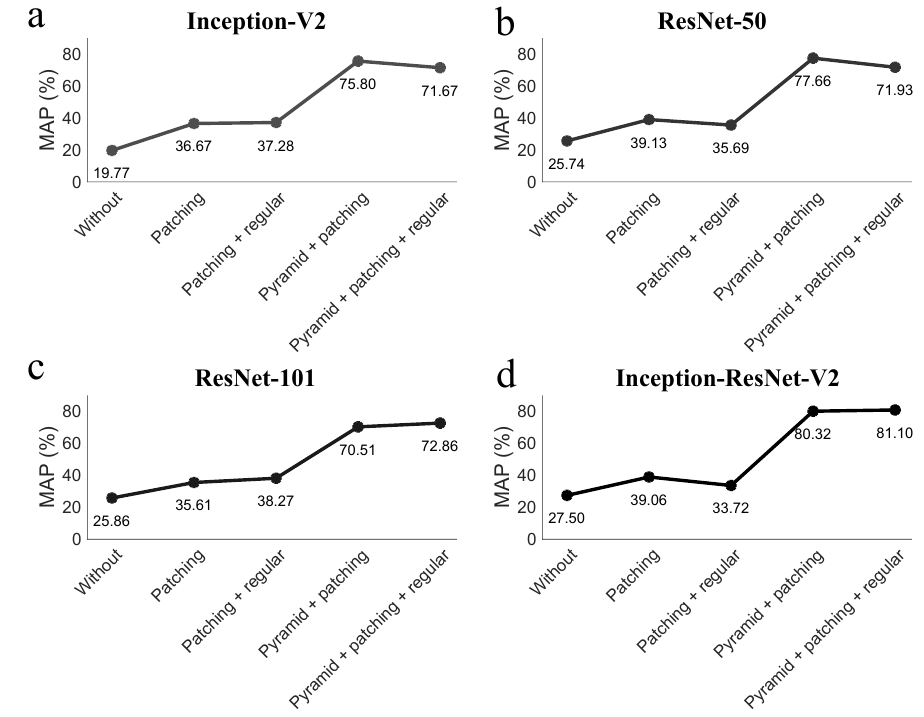
Figure 5. Comparison of the precision of trained models using various network architectures and augmentation